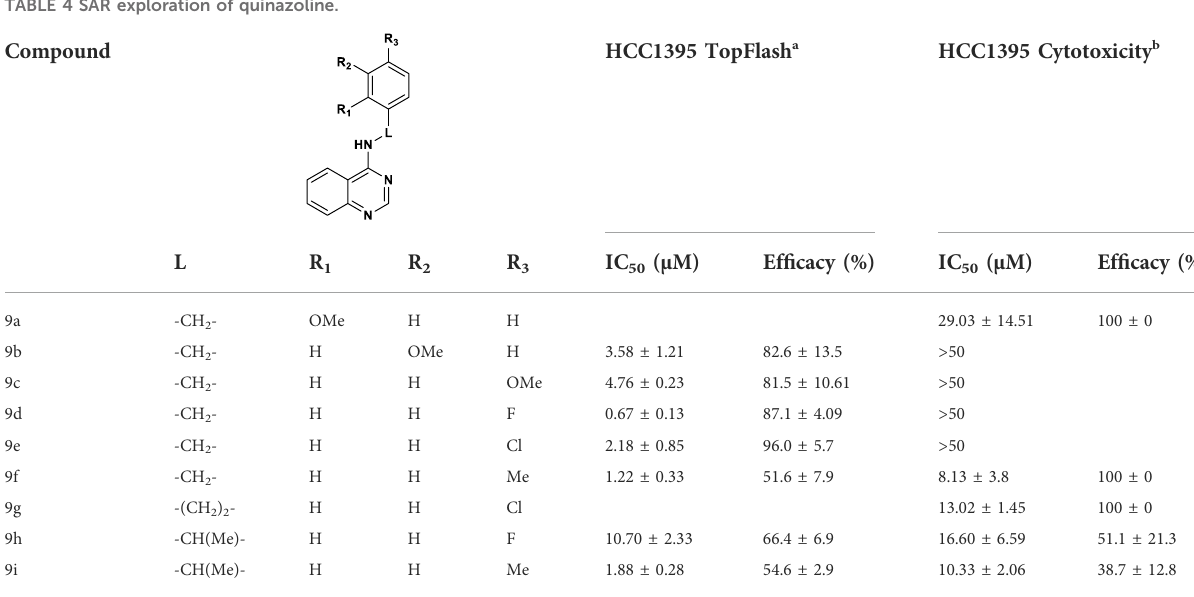
TABLE 4 SAR exploration of